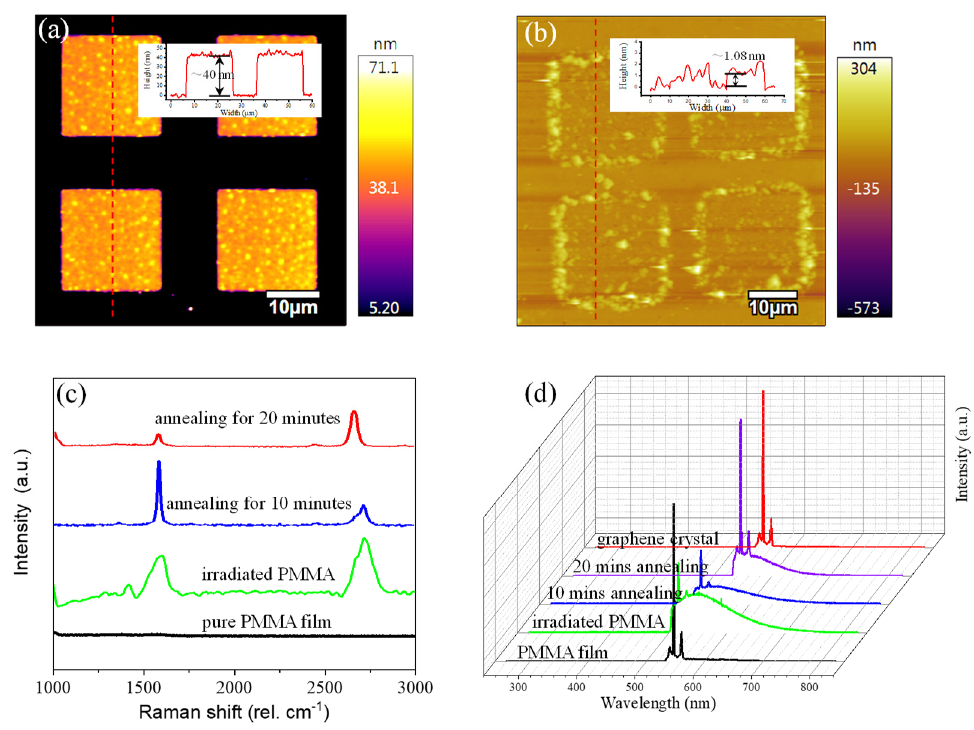
Figure 4. AFM view of the sample ( a ) before, and ( b ) after annealing at 900 °C in a vacuum atmosphere. ( c , d ) Raman and photoluminescent spectra of the sample at the different preparation stages.